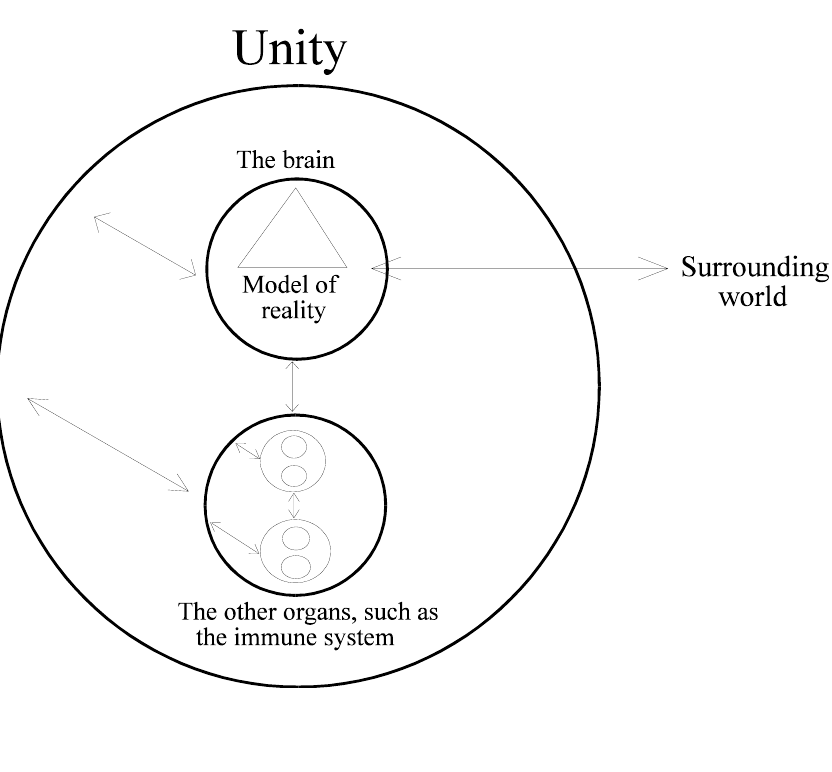
FIGURE 1. The wholeness of human being (see text for